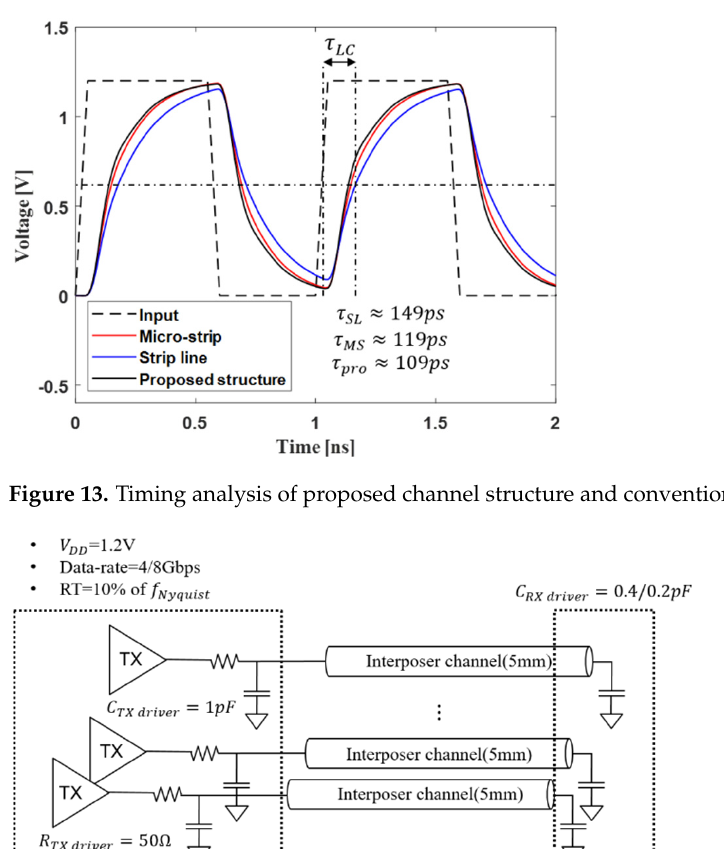
Figure 13. Timing analysis of proposed channel structure and conventional channel structure.